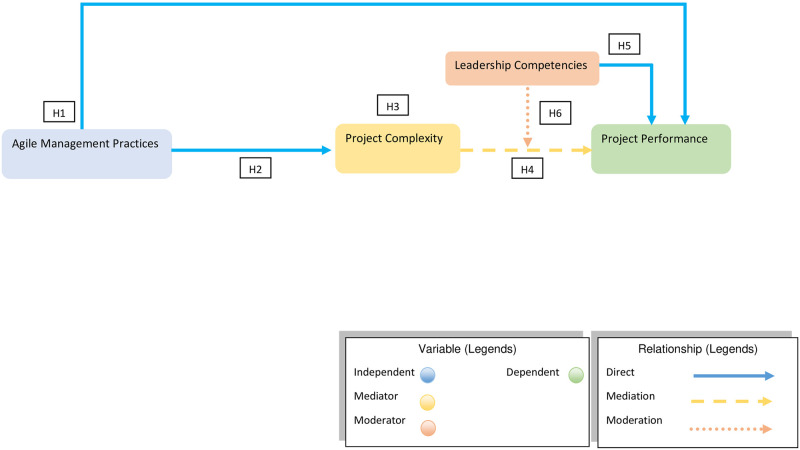
Conceptual model.